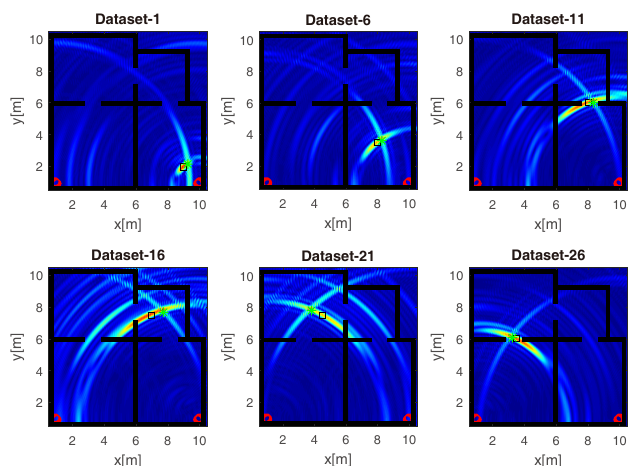
Figure 13. Tomographic images of a UWB source achieved with array data fusion (C). Array (red circles); true source position (black square); estimated source position (green asterisk). Color scale is [0, 1].